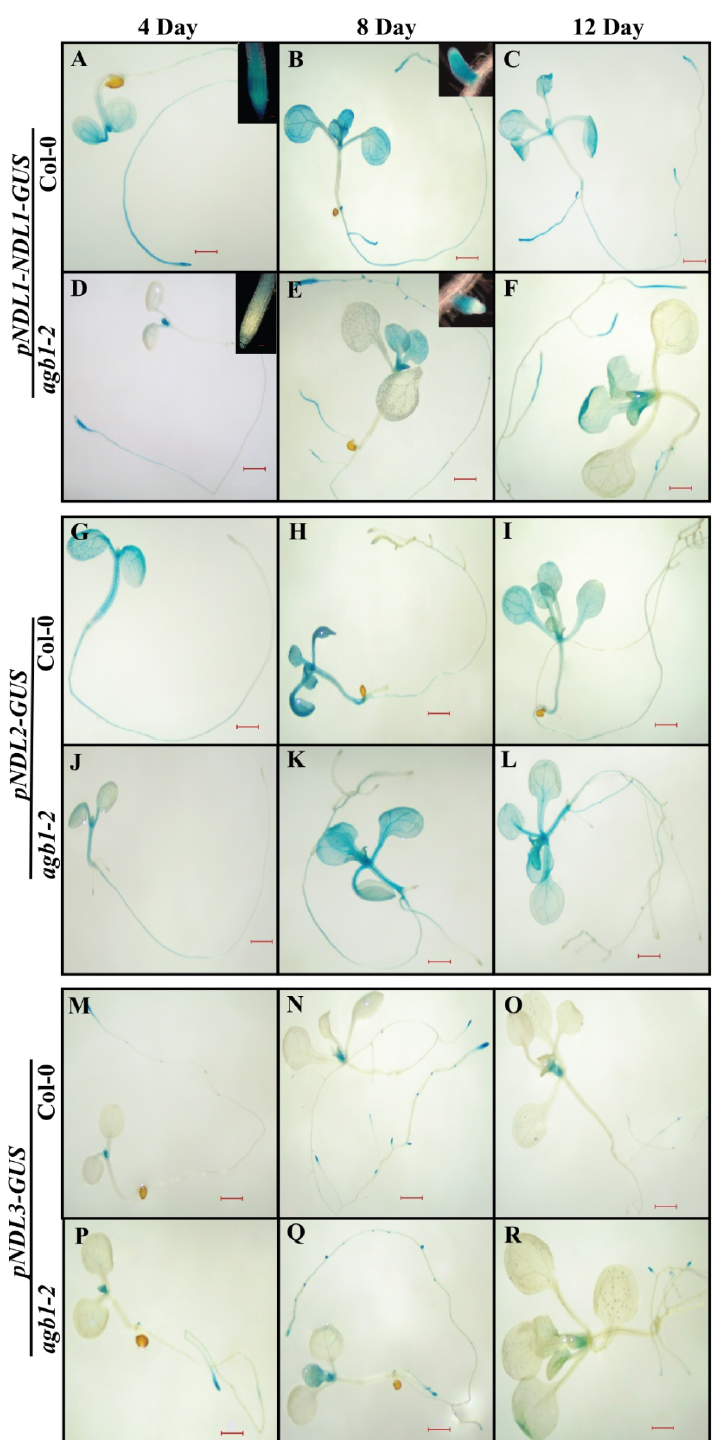
Figure 3. In planta expression analysis of NDL gene family during di ff erent developmental stagesin presence and absence of AGB1 : ( A-C, G-I and M-O ). Histochemical GUS staining of pNDL1-NDL1-GUS , pNDL2-GUS and pNDL3-GUS seedlings in wild type Col-0 background. ( D-F, J-L and P-R ). Histochemical GUS staining of pNDL1-NDL1-GUS , pNDL2-GUS and pNDL3-GUS seedlings in agb1-2 mutant background. Histochemical GUS analysis in transgenic Arabidopsis plants during di ff erent stages of development was carried out 4 day, 8 day, and 12 day old seedlings were analyzed. GUS expression is under the control of NDL2 and NDL3 promoter and translational fusion in case of NDL1 , Scale Bar = 0.2 µ